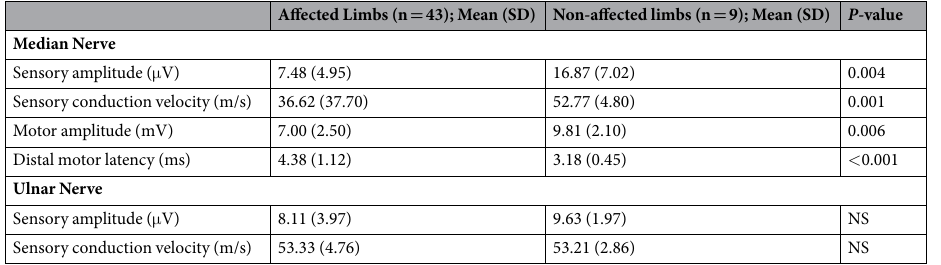
Table 3. Neurophysiology data of patients with carpal tunnel syndrome. μ V = microvolt; m/s = meter/second; mV = millivolt; ms = millisecond; NS = not